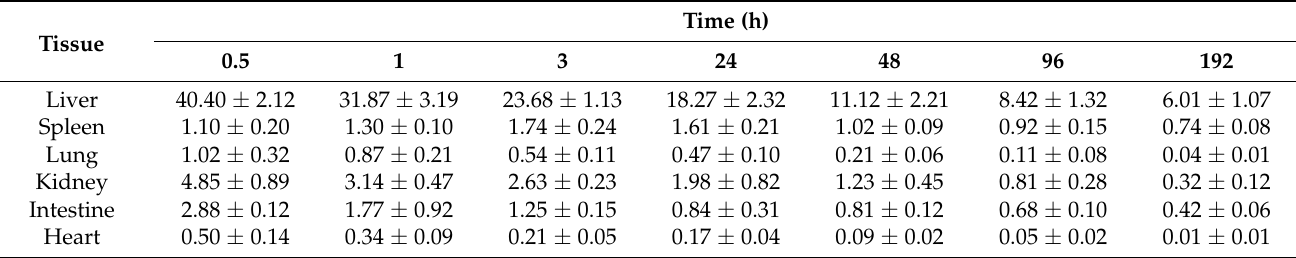
Table 3. Biodistribution of the 225 Ac-rHDL nanosystem in healthy mice (Balb-c) after intravenous injection. The percentage of the injected dose per organ (% ID), at various times, is shown (mean ± SD, n = 3).